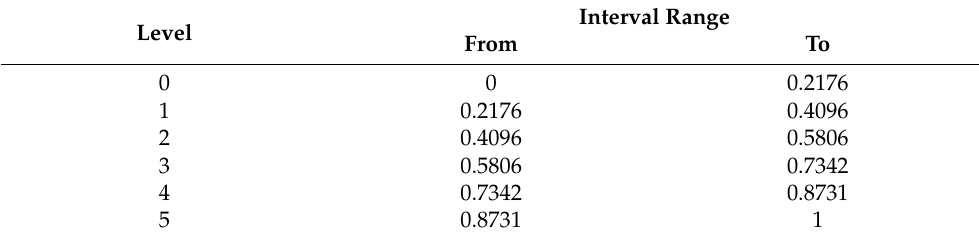
Table 1. Interval range and corresponding